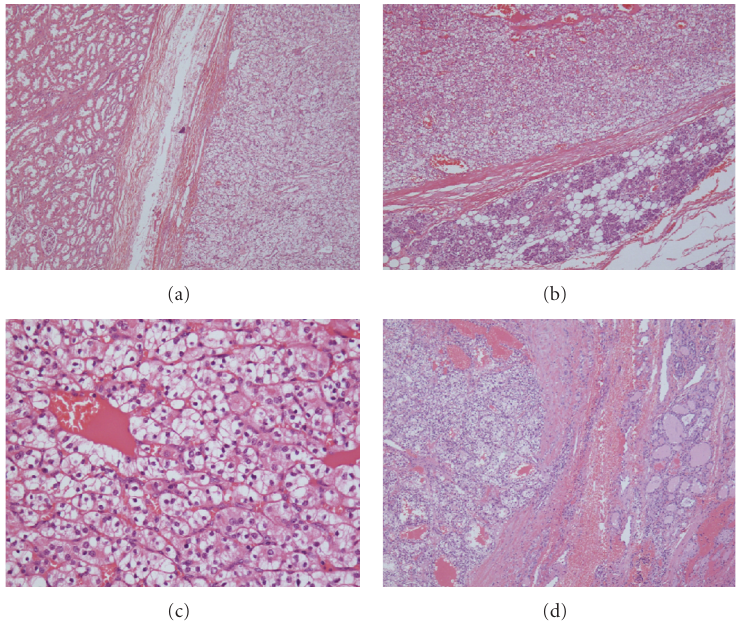
Figure 2: (a) Original renal tumour (H&E stain, original magnification x40). On the left is normal kidney and clear cell RCC is on the right. (b) Submandibular gland (H&E stain, original magnification x40): metastatic RCC on the top with normal glandular tissue in the lower portion. (c) Metastatic RCC in submandibular gland (H&E stain, original magnification x200). (d) Thyroid tumour (H&E stain, original magnification x40): tumour on the left and normal thyroid tissue on the